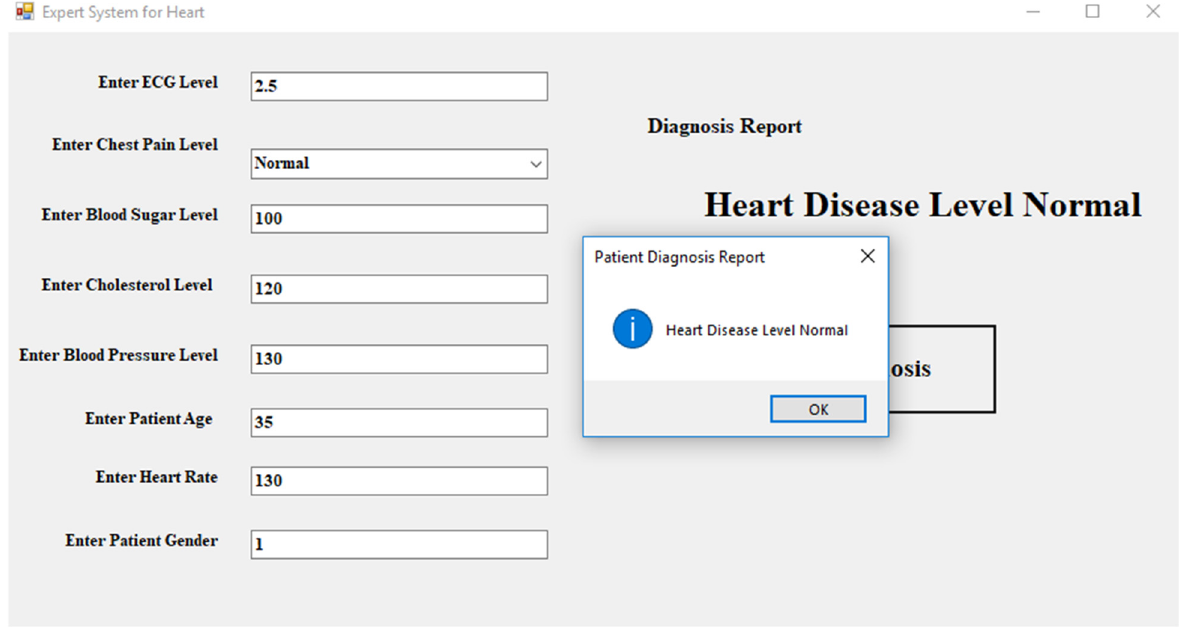
Figure 11. ECG 2.5, Chest Pain Normal, Sugar 100, Cholesterol 120, BP 130, Age 35, Heart Rate 130 and Gender Male, output system is “Normal”.